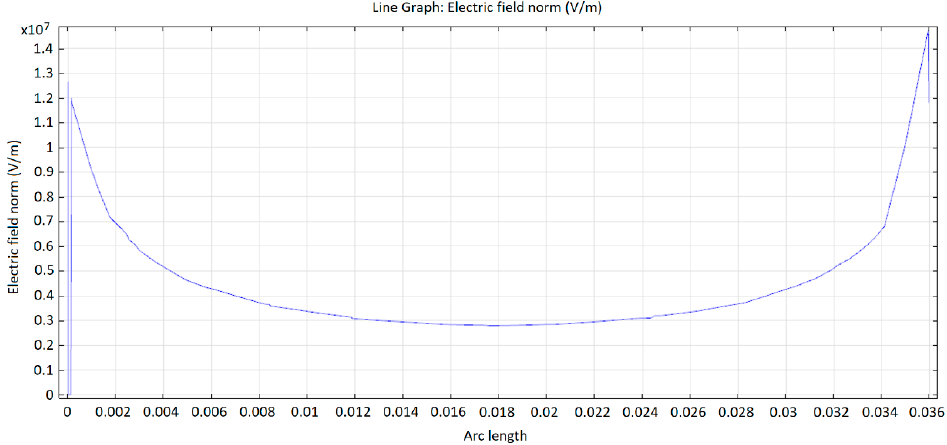
Figure 30. Results of the electric field distribution along the measurement lines for large lamellas.